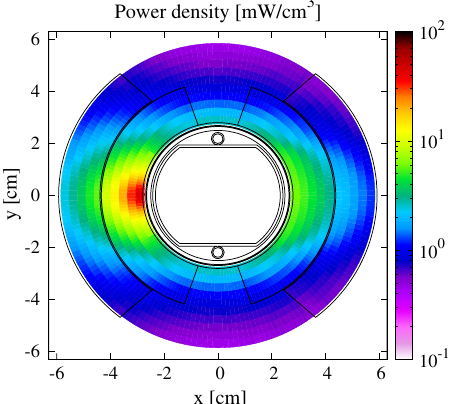
FIG. 18. Simulated transverse power density distribution from FLUKA during the steady-state collimation quench test at the MB.A9L7 maximum in Fig. 17 (down). The beam direction enters the figure. Recall from Sec. III that in FLUKA coils are extruded, not adequately representing the coil